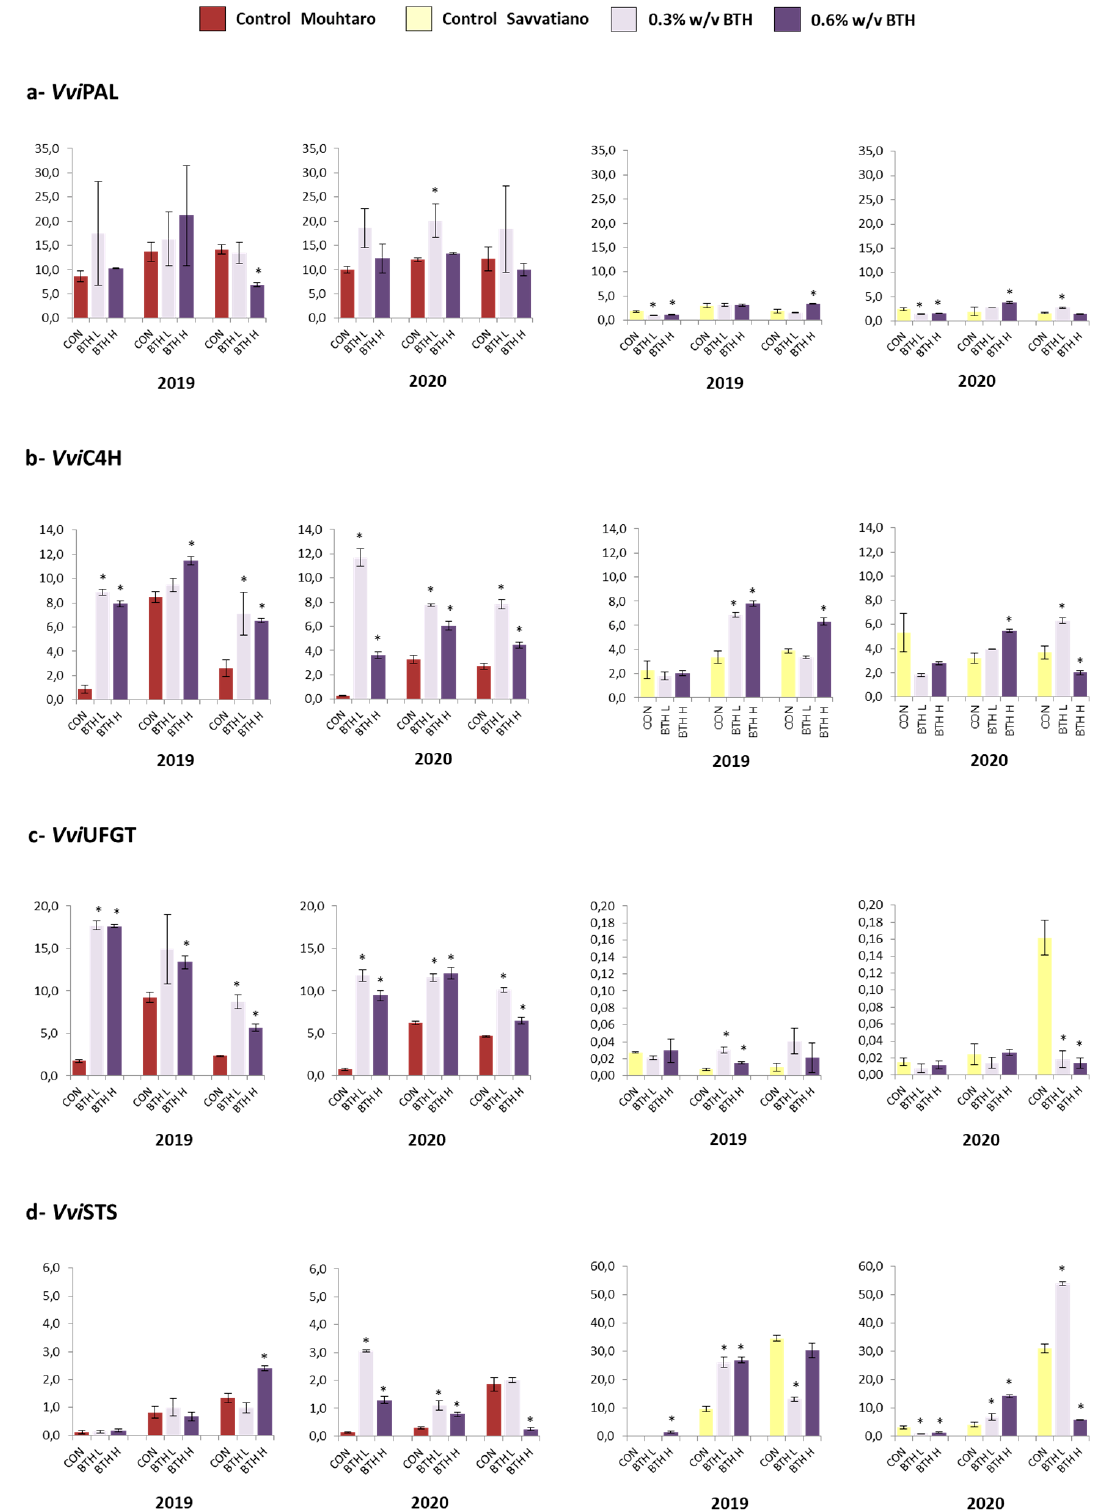
Figure 3. The expression level of genes involved in the phenylpropanoid pathway: VviPAL ( a ), VviC4H ( b ), VviUFGT ( c ), and VviSTS ( d ) in Mouhtaro and Savvatiano during two growing seasons (2019 and 2020). Vertical bars represent the standard deviation and asterisks indicate the statistically significant differences (Student’s t -test. p –value < 0.05). The three sampling points (veraison, middle veraison, and harvest) are indicated under each